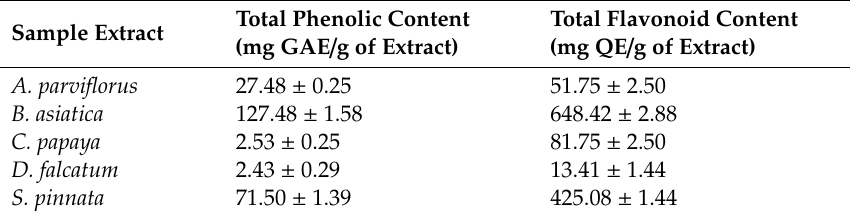
Table 3. The TPC and TFC values a of the five extracts.